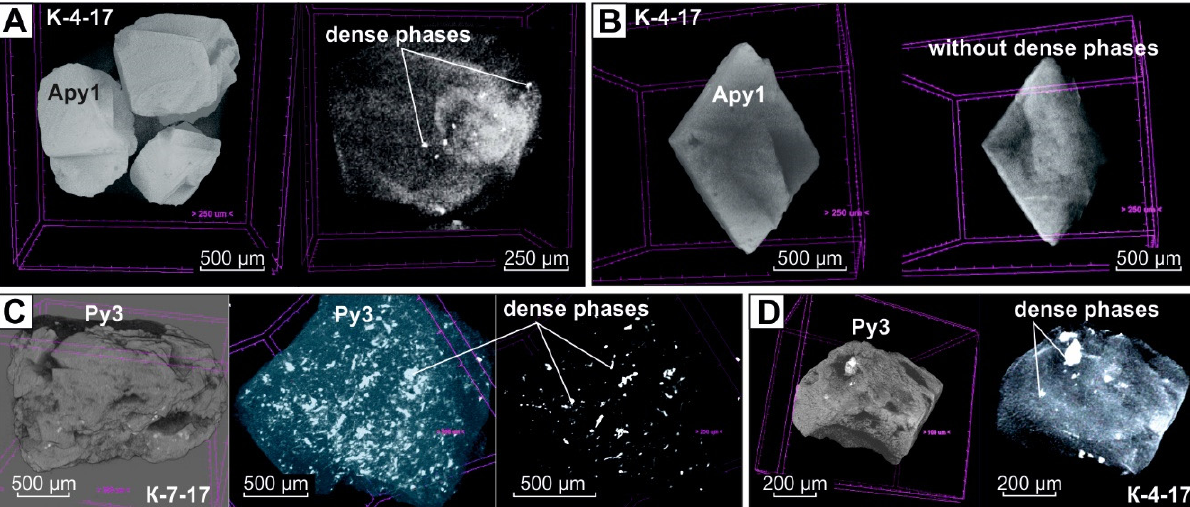
Figure 7. Three-dimensional visualization of Py3 and Apy1 of Khangalas deposit. ( A ) Apy1 grains with inclusions of dense minerals (galena, gold); ( B ) Apy1 without inclusions of x-ray contrasting phases; ( C , D ) Py3 aggregate with included dense minerals (galena, gold).